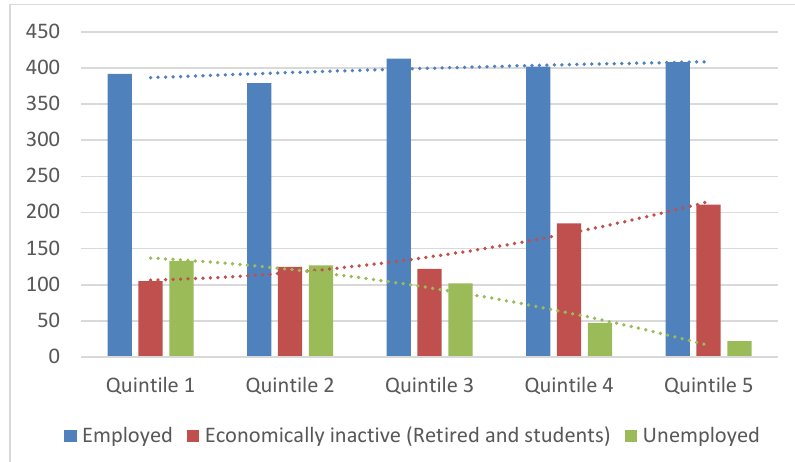
FIGURE 1: Effect of employment group on net equity quintile Source: